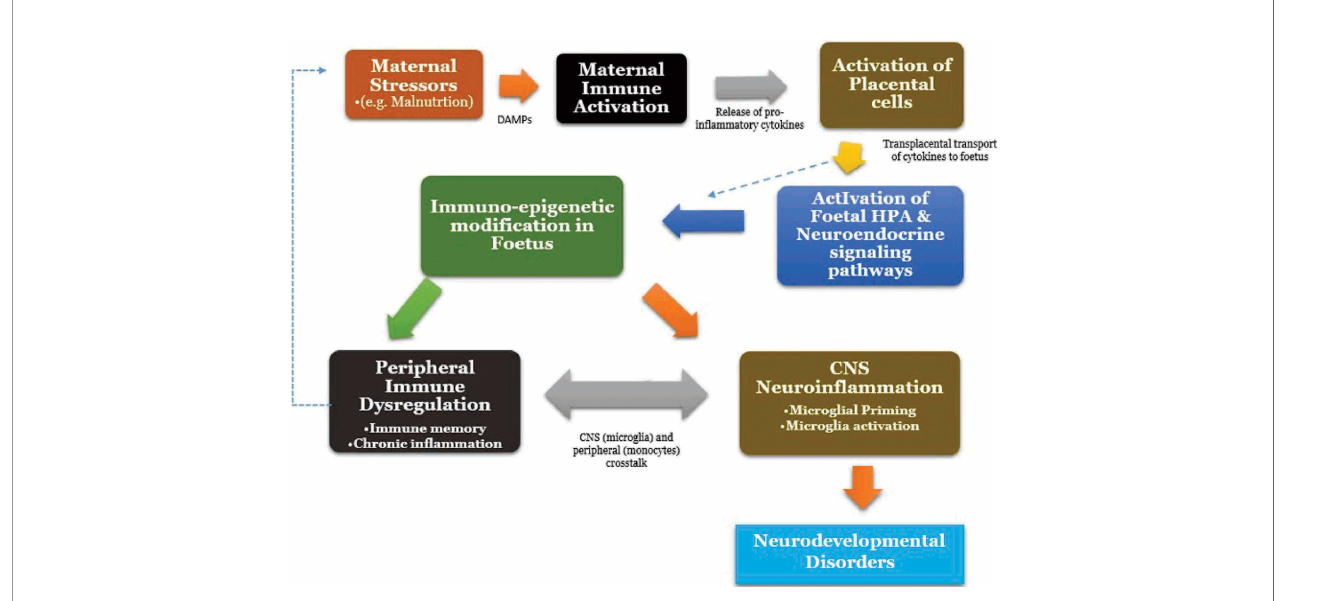
FIGURE 1 | Malnutrition and Maternal immune activation, Neuroin fl ammation Crosstalk. HPA, Hypothalamic-Pituitary-Adrenal